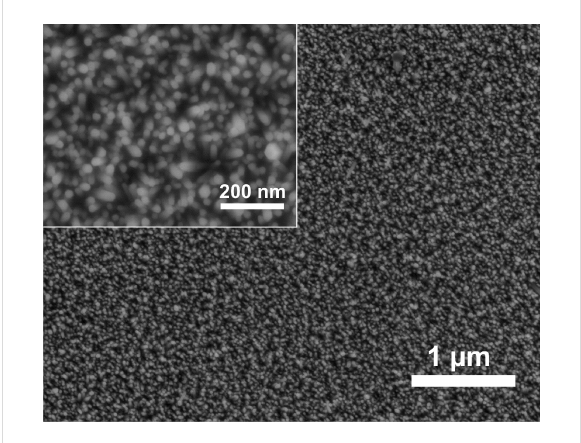
Figure 2: SEM micrographs of a ZnO nanorod array grown on a seeded glass slide for 1 h without the addition of HYA; the inset shows a higher magnification image.